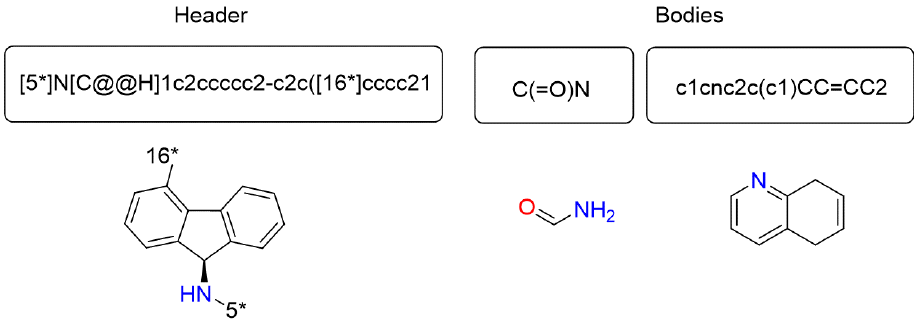
Figure 4. Representation example: A solution composed by one header and two